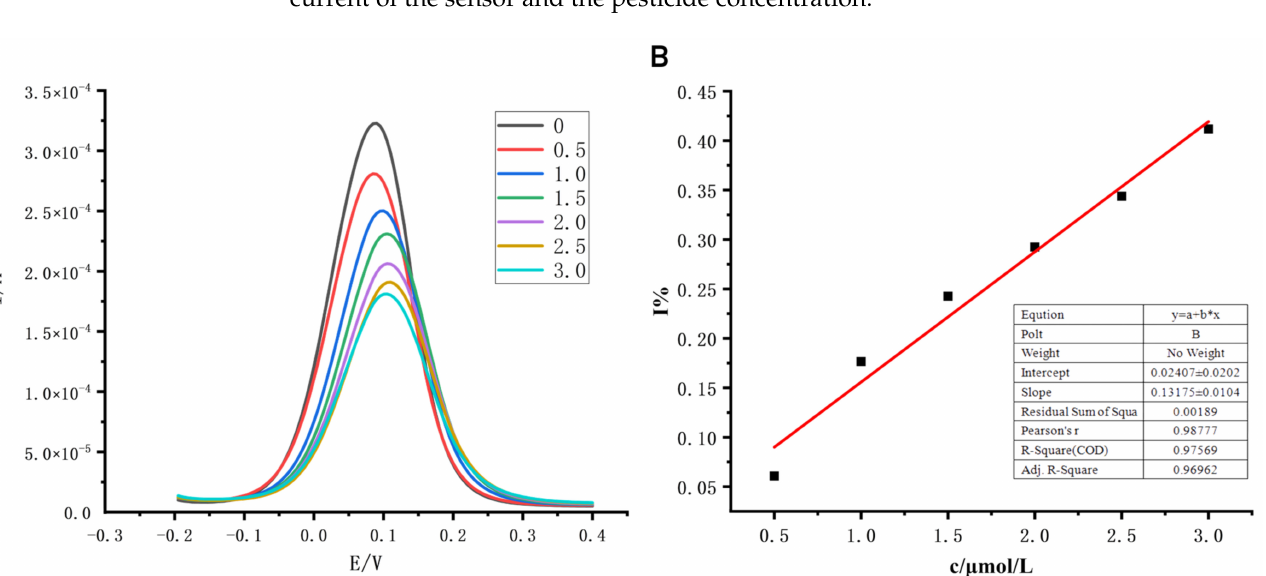
Figure 4. Standard curve and relative suppression curve of cyromazine solution with different con- centrations. Note: ( A ) DPV curve of the molecularly imprinted sensor with different concentrations of cyromazine, the ( B ) curve of relative suppression of the molecularly imprinted sensor with different concentrations of cyromazine; 0, 0.5, 1.0, 1.5, 2.0, 2.5, 3.0 are different concentrations of cyromazine, where the concentration unit is µ